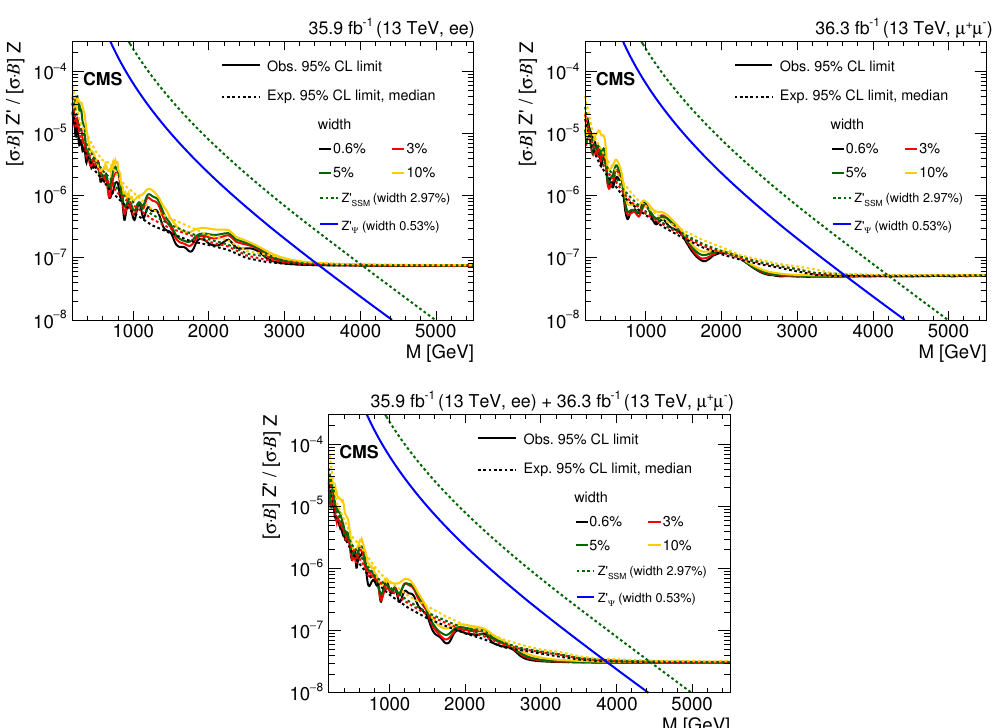
Figure 4 . The upper limits at 95% CL on the product of production cross section and branching fraction for a spin-1 resonance, for widths equal to 0.6, 3, 5, and 10% of the resonance mass, relative to the product of production cross section and branching fraction for a Z boson, for the dielectron channel (left), dimuon channel (right), and their combination (lower). Theoretical predictions for the spin-1 Z 0 and Z 0 resonances are also shown. SSM